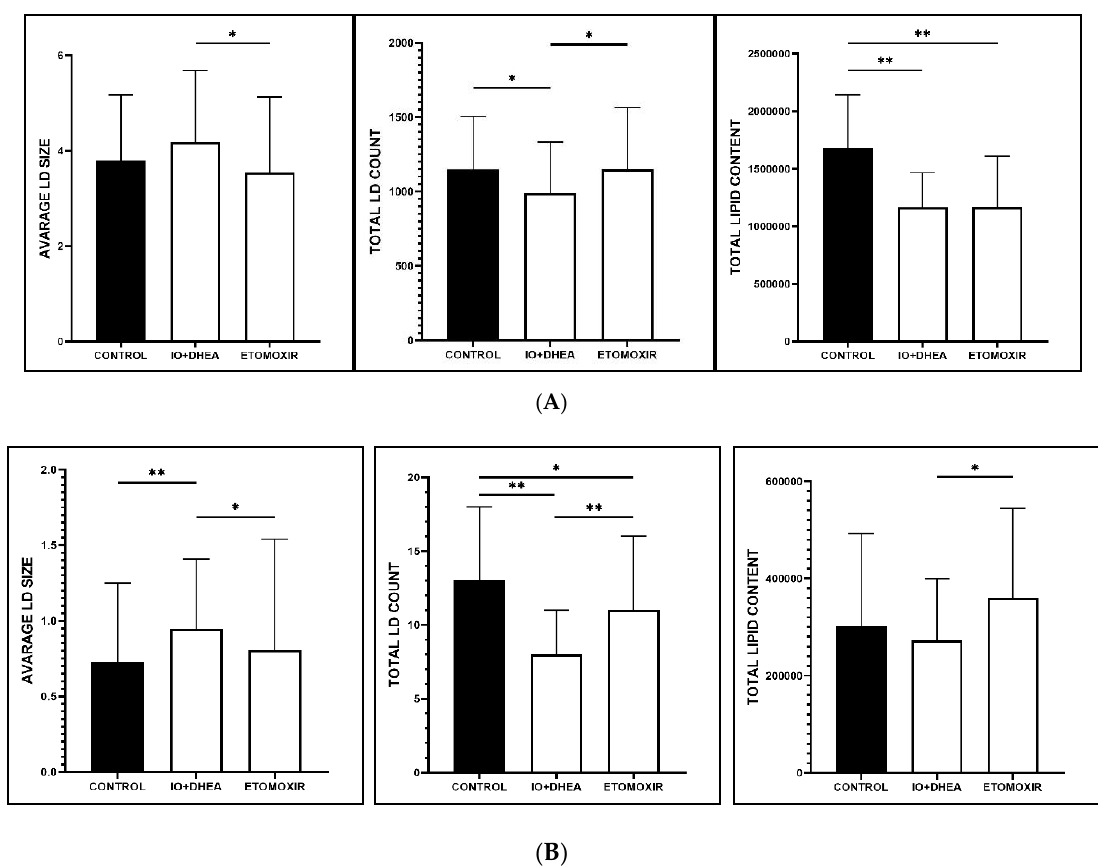
Figure 5. The effect of glucose (IO+DHEA) and fatty acid (ETOMOXIR) metabolism inhibition on the lipid droplets parameters in ( A ) oocytes and ( B ) cumulus cells (means ± SD). * — p ≤ 0.05, ** — p ≤ 0.01.